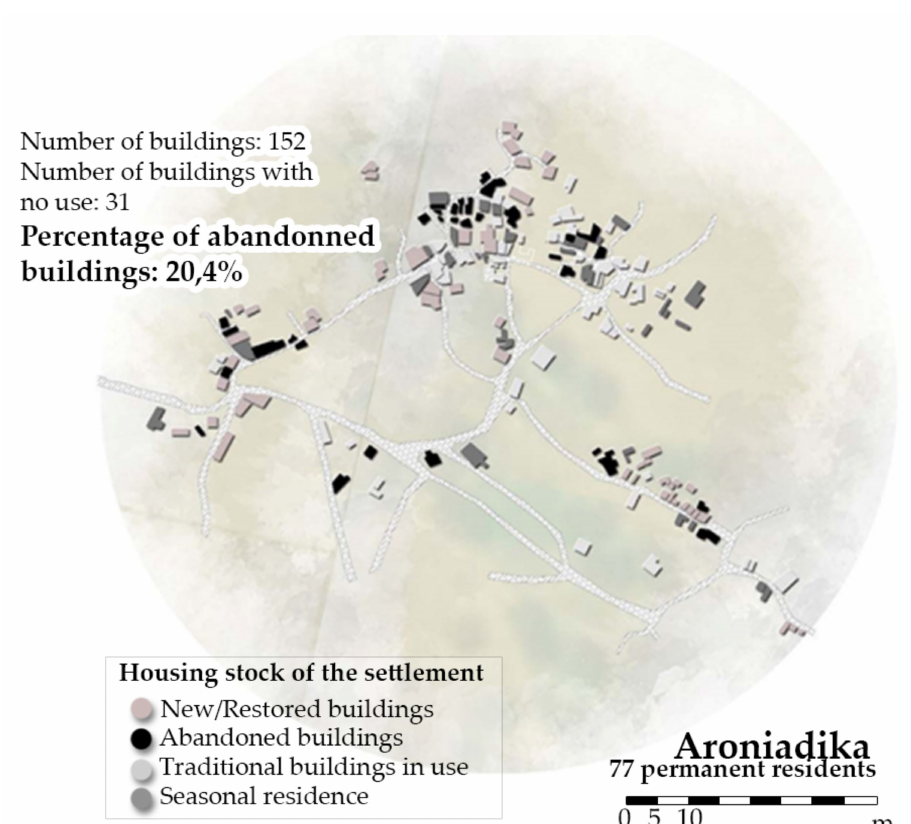
Figure 25. The housing stock of